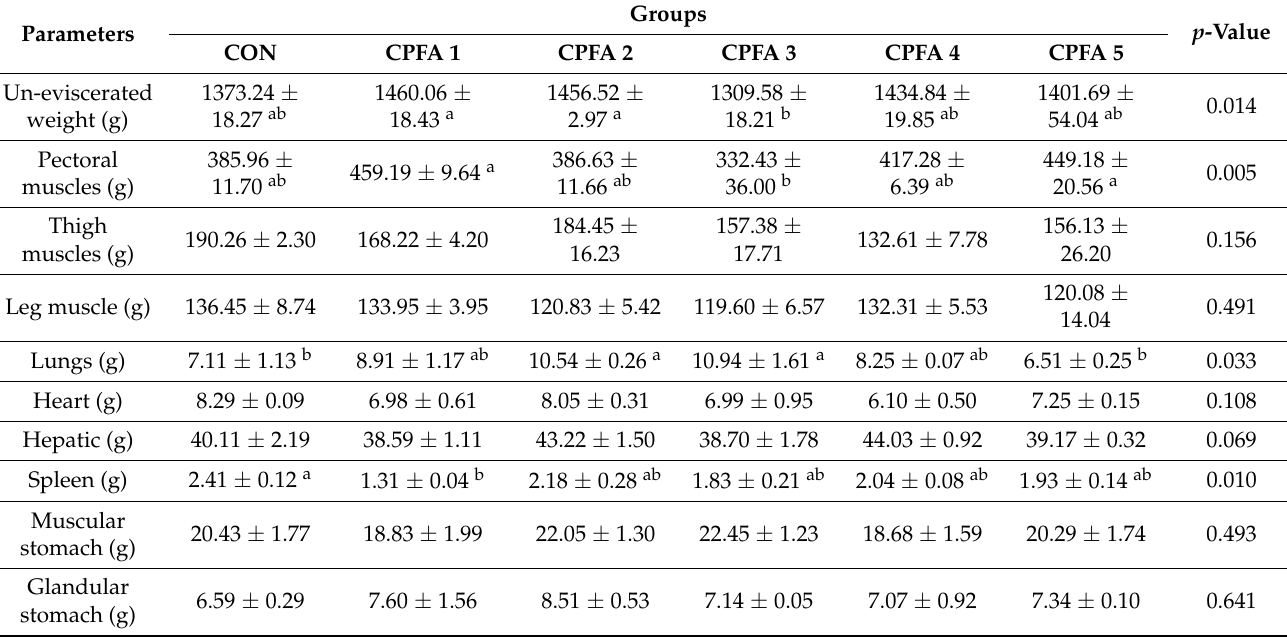
Table 6. Carcass indicators and weight of internal organs of broiler